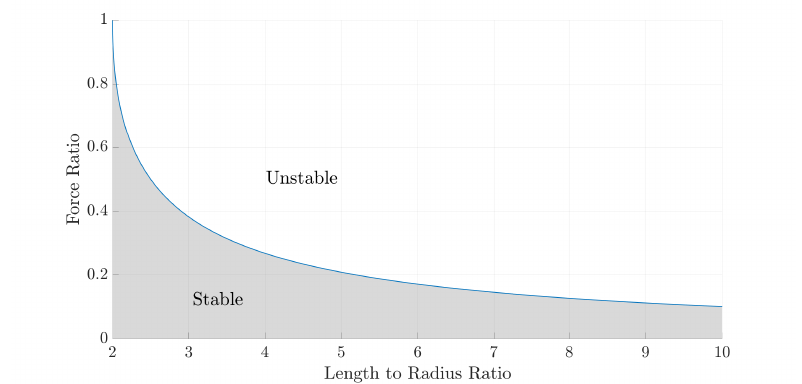
Figure 22. Force ratio against the length-to-radius